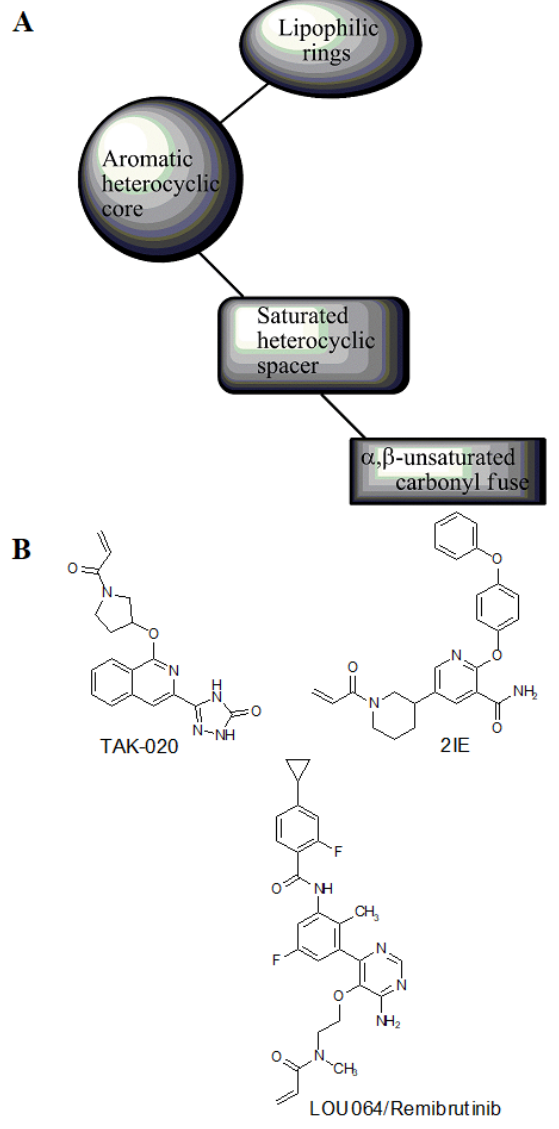
Figure 6. ( A ) Complementary structural features of covalent inhibitors of BTK-kinase domain; ( B ) structures of novel covalent BTK inhibitors deposited in PDB.